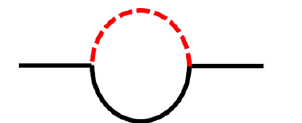
Figure 2. Diagrams contributing to the beta function at order 1 /N .